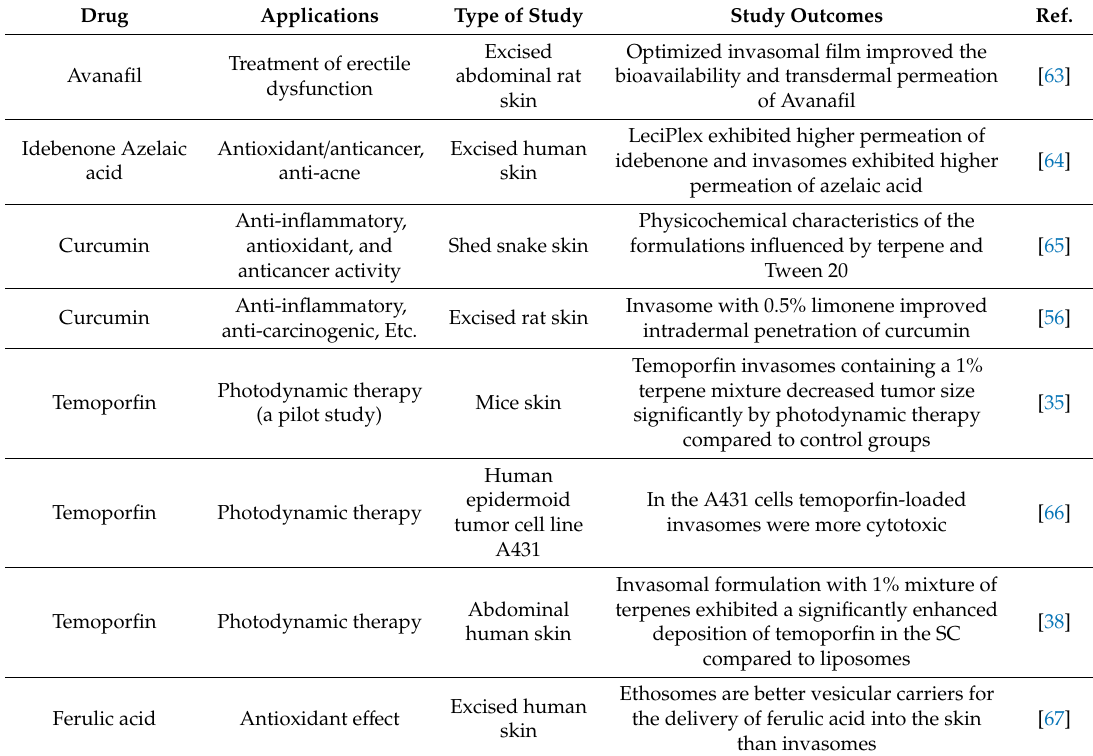
Table 1. Therapeutic application of